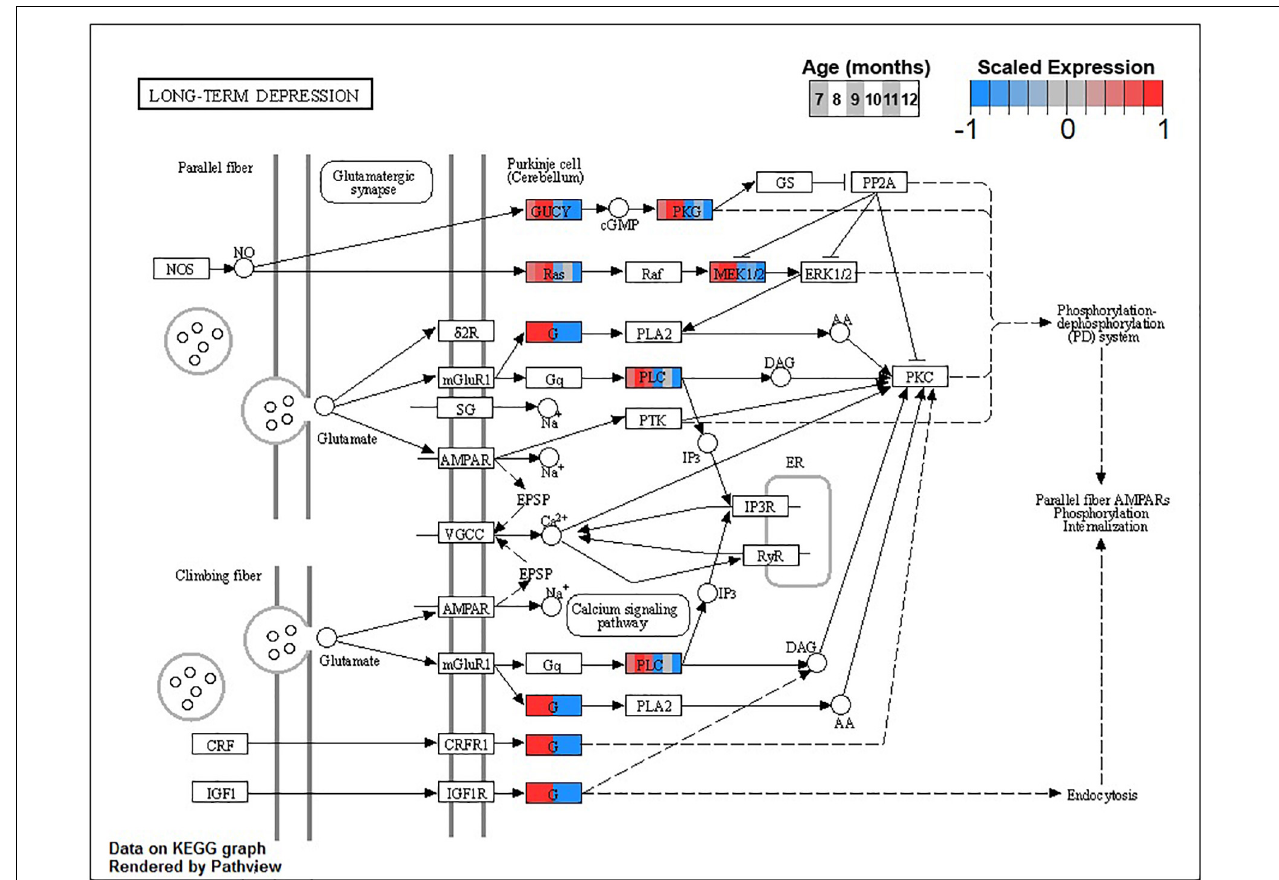
FIGURE 6 | Expression of orthologs annotated for the Kyoto Encyclopedia of Genes and Genomes (KEGG) long-term depression (ko04730) pathway present in buccal S sensory neuron (BSC) expression clusters with decreasing trend (B3 and B4). Each node of the pathway diagram represents an ortholog assigned to an Aplysia californica transcript. Nodes are divided into six colored sections, from left to right, ages 7 to 12 months. Node sections are colored according to their mean centered and variance scaled expression, together representing the expression trends of each node across the aging process. Nodes that are not colored were absent from the gene sets of expression clusters B3 and B4. Pathway enrichment demonstrates broad downregulation of key signaling cascades in